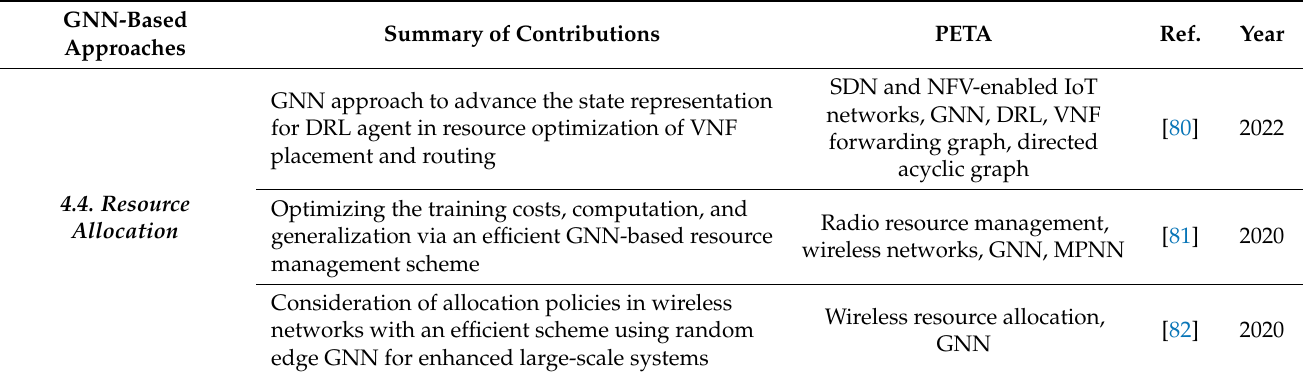
Table 6. Summary of Selected Works in GNN-Based Resource Allocation Softwarization Policies. GNN-Based